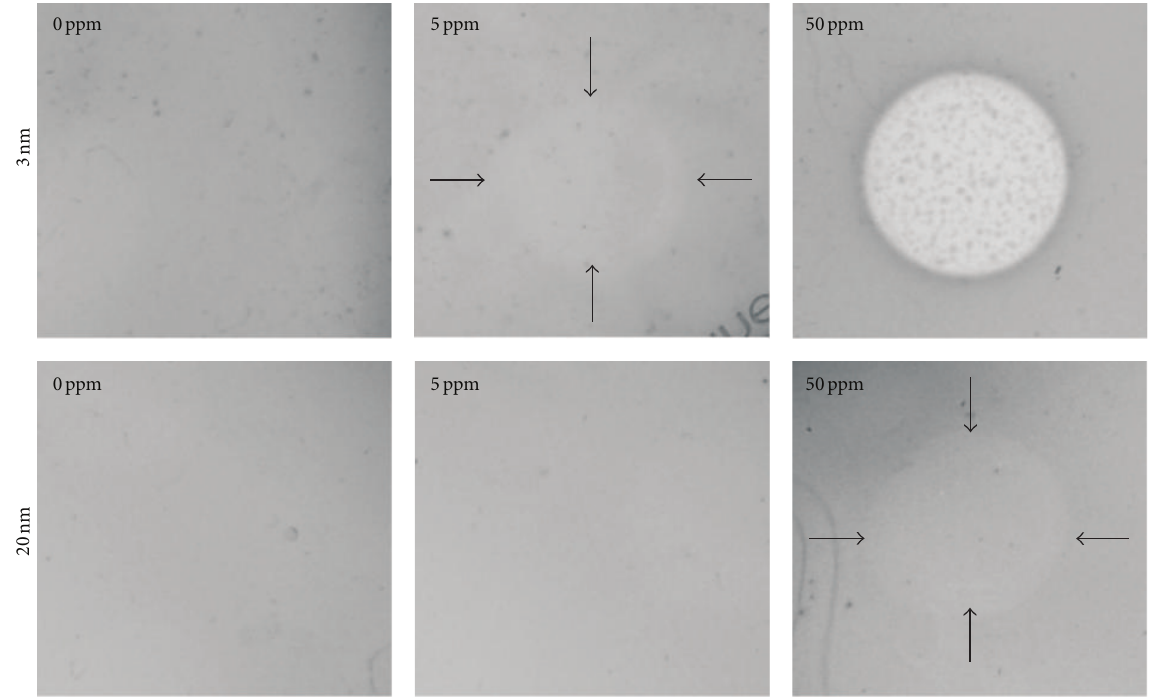
Figure 6: Antibacterial effect of Ag NPs with different sizes and concentrations against E. coli (ATCC 25922) lawn on LB agar. Turbid zones are marked with